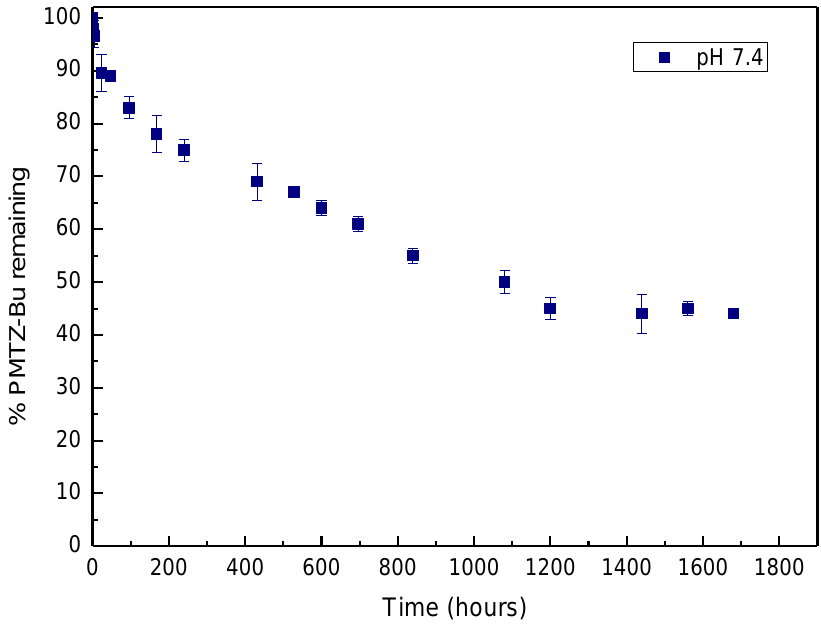
Figure 3. Degradation profile of the antibacterial polymer PMTZ-Bu at pH 7.4.